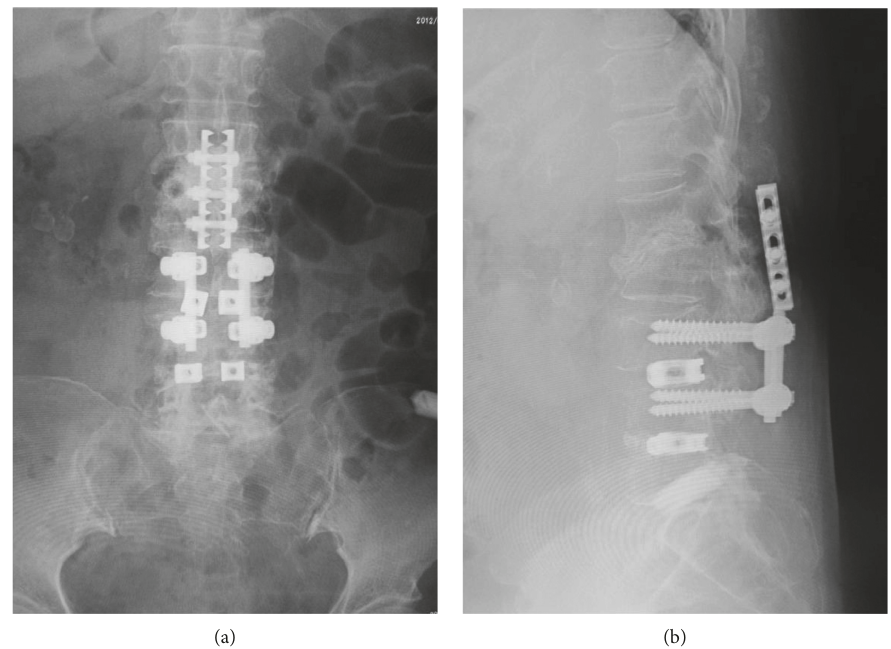
Figure 6: Case 2: plain anteroposterior (a) and lateral (b) radiographs following the final surgery with a spinous process plate and iliac crest bone